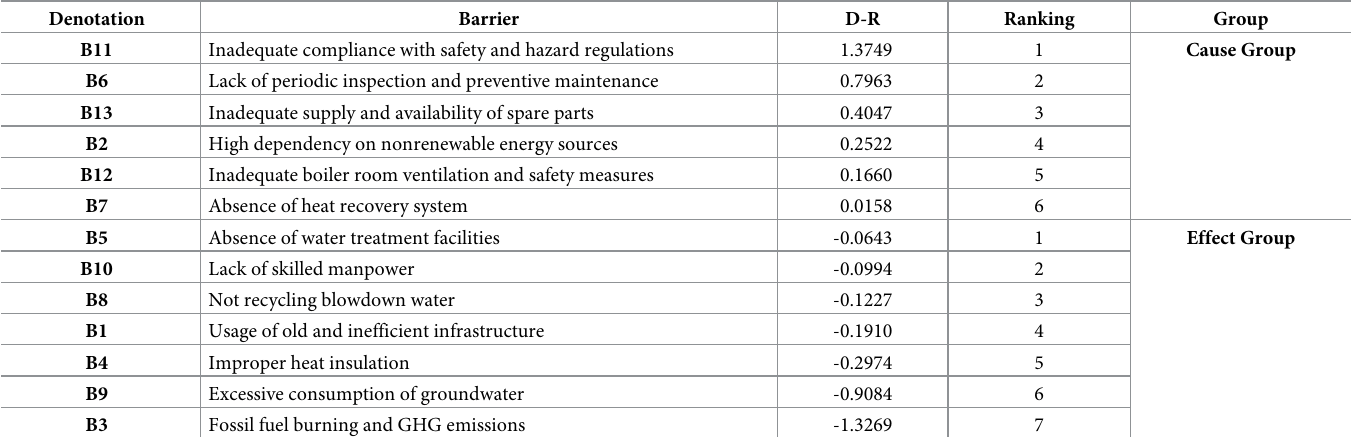
Table 5. Causal ranking of the barriers (the cause group and the effect group).